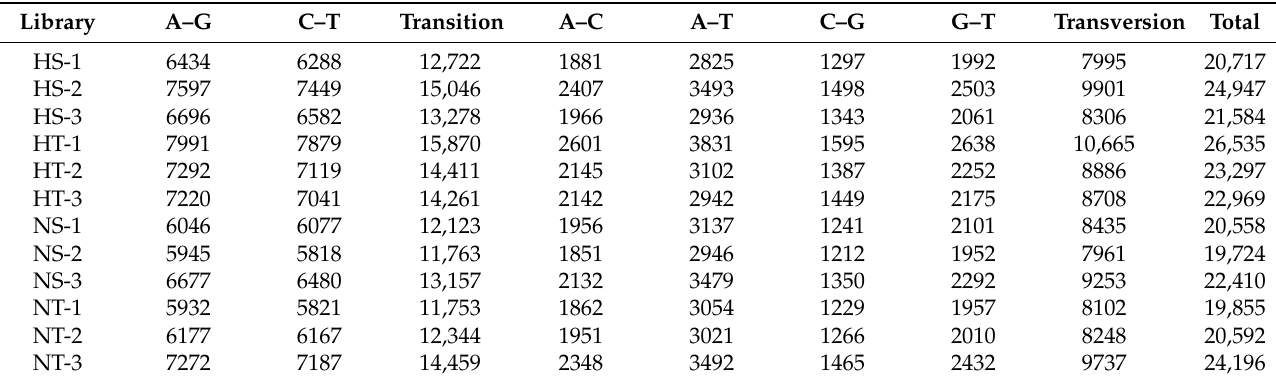
Table 4. Statistics of SNP variant type and number.